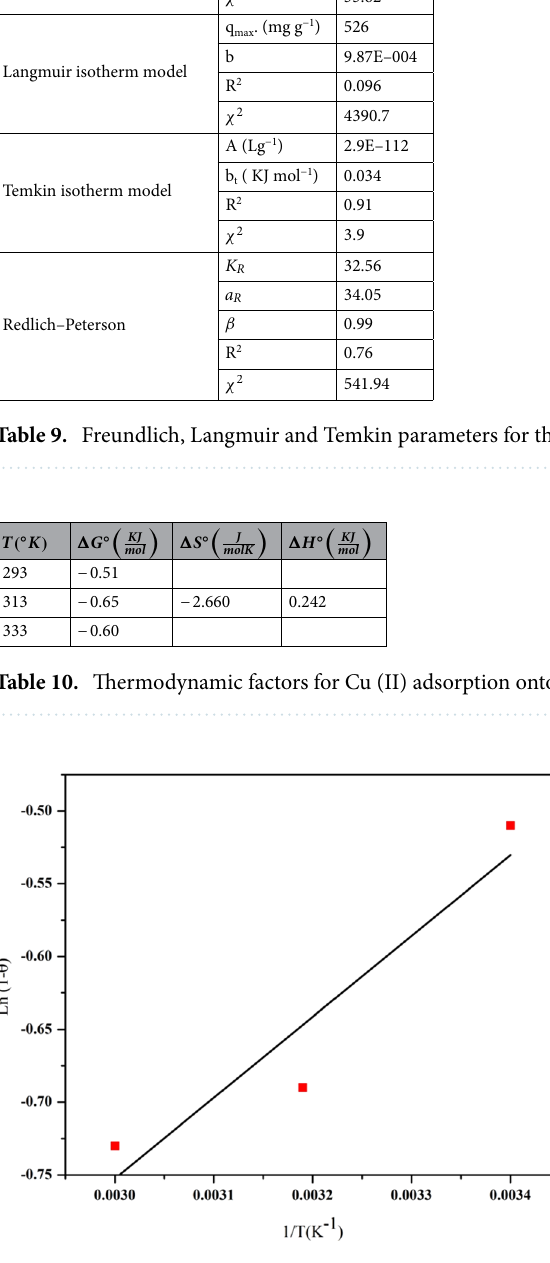
Figure 15. Graph of Ln (1 − θ) versus 1/T for uptake of Cu 2+ ions on